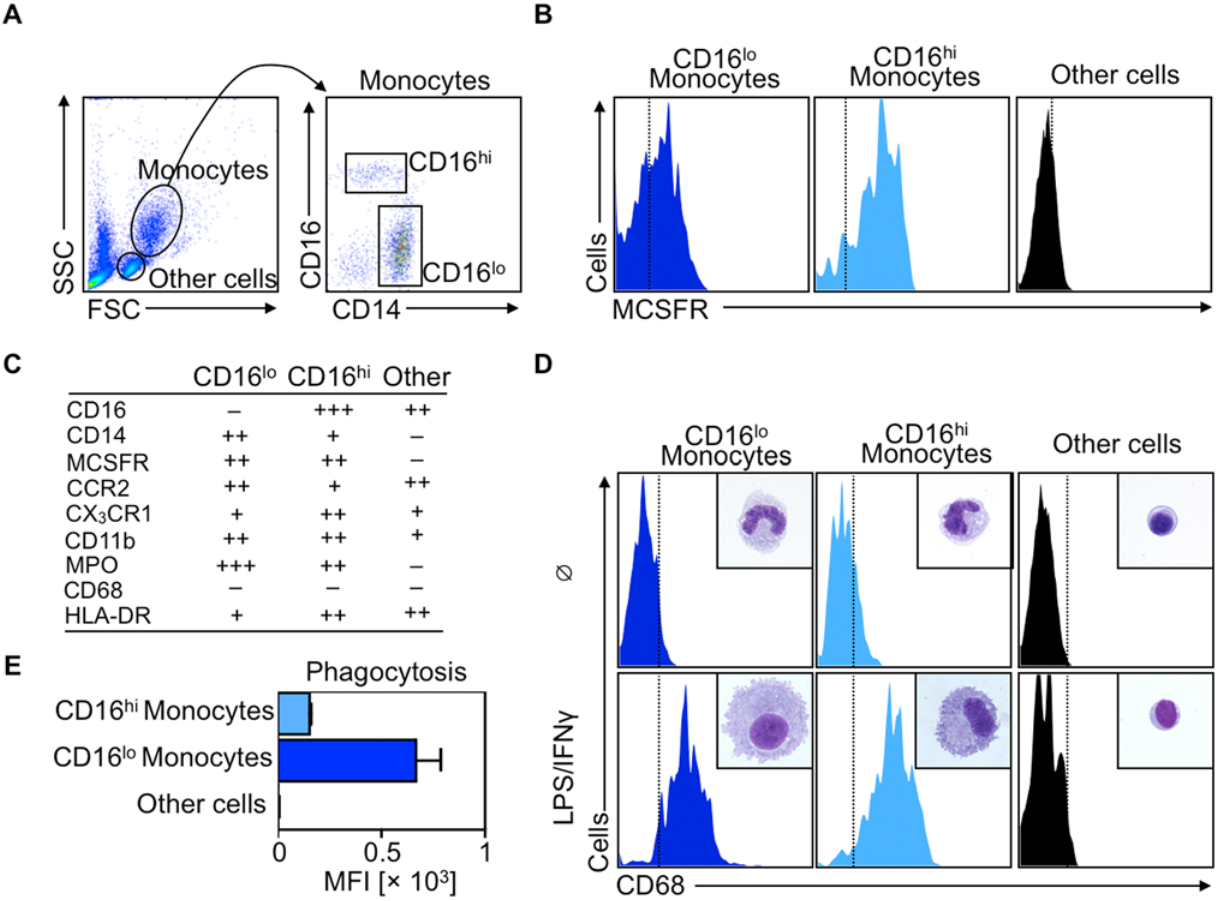
Figure 1. Human monocyte subsets differ phenotypically and functionally. A. Flow cytometry dot plots show forward scatter (FSC) versus side scatter (SSC) of mononuclear cells obtained from fresh blood. A monocyte gate is drawn and monocyte subsets are identified according to their CD14 and CD16 expression profile. B. Histograms depict MCSFR expression of CD16 lo monocytes, CD16 hi monocytes and other cells (mostly lymphocytes). C. Table summarizes relative expression profiles of selected markers for CD16 lo , CD16 hi monocytes and other cells. D . Representative histograms and H&E cytospin preparations show CD68 expression and morphology of CD16 lo , CD16 hi monocytes and other cells freshly isolated ( % ) or after in vitro culture for 6 days with LPS/IFN c . E. Bar graph depicts ex vivo phagocytosis of fluorescently labeled latex beads in CD16 lo , CD16 hi monocytes and other cells (n=4).